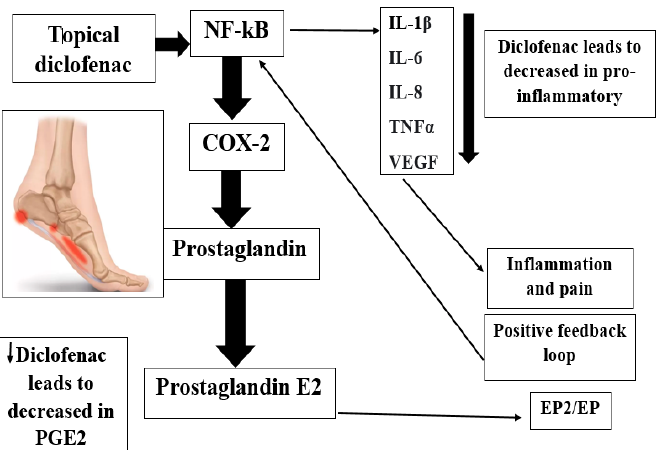
Figure 1. Mechanism of action of diclofenac potassium. NF- κ b: Nuclear Factor-Kappa B; COX-2: Cyclooxygenase-2; PGE2: Prostaglandin E2 (dinoprostone); IL-1 β : Interleukin-1beta (lymphocyte activating factor (LAF)); IL-6: Interleukin-6 (B-cell stimulatory factor -2 (BSF-2)); IL-8: Interleukin-8 ( α chimiokine); TNF- α : Tumor Necrosis Factor-alpha; VEGF: Vascular Endothelial Growth